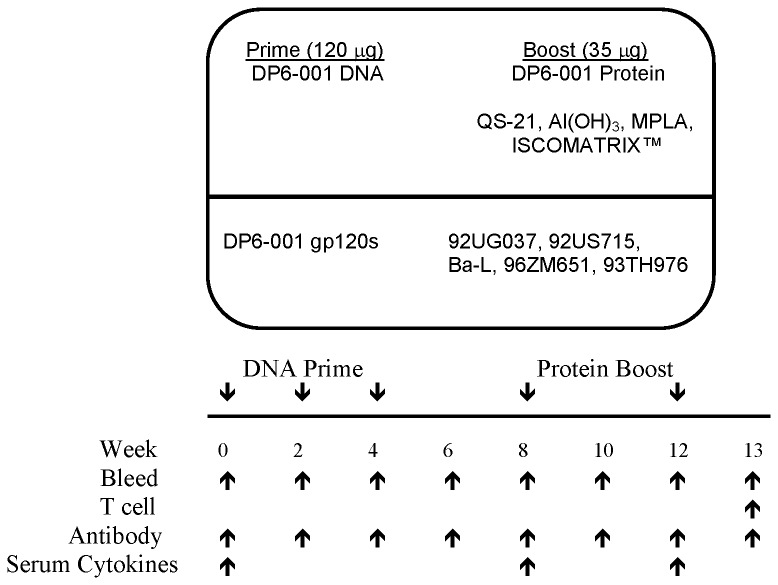
Study design and immunization schedule.C57Bl/6 mice were immunized with three pentavalent DNA primes followed by two heterologous gp120 protein boost. The pentavalent vaccine mixture of both DNA and protein components consisted of HIV-1 Env from clades A (92UG037.8), B (92US715.6 and Bal), C (96ZM651), and E (93TH976.17). DNA and protein doses indicated are for a total of five immunogens at each immunization. Four adjuvants were tested individually as part of the protein boost. Time points of immunizations, and sample collections for different assays were indicated.